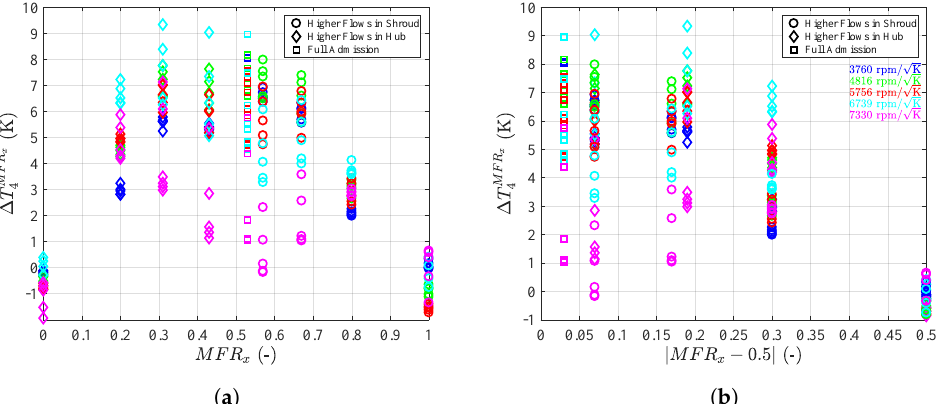
Figure 21. Error prediction in all admission conditions using the extreme flow maps for T#1TE. ( a ) Mixed turbine outlet temperature error with MFR, ( b ) Mixed turbine outlet temperature error with MFR (cid:48) x